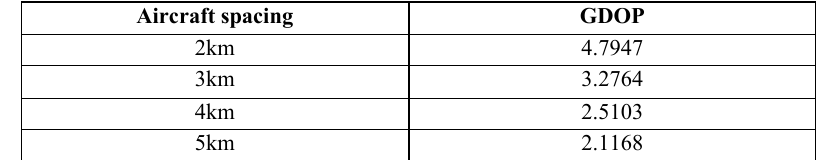
Table 1. The relationship between aircraft spacing and